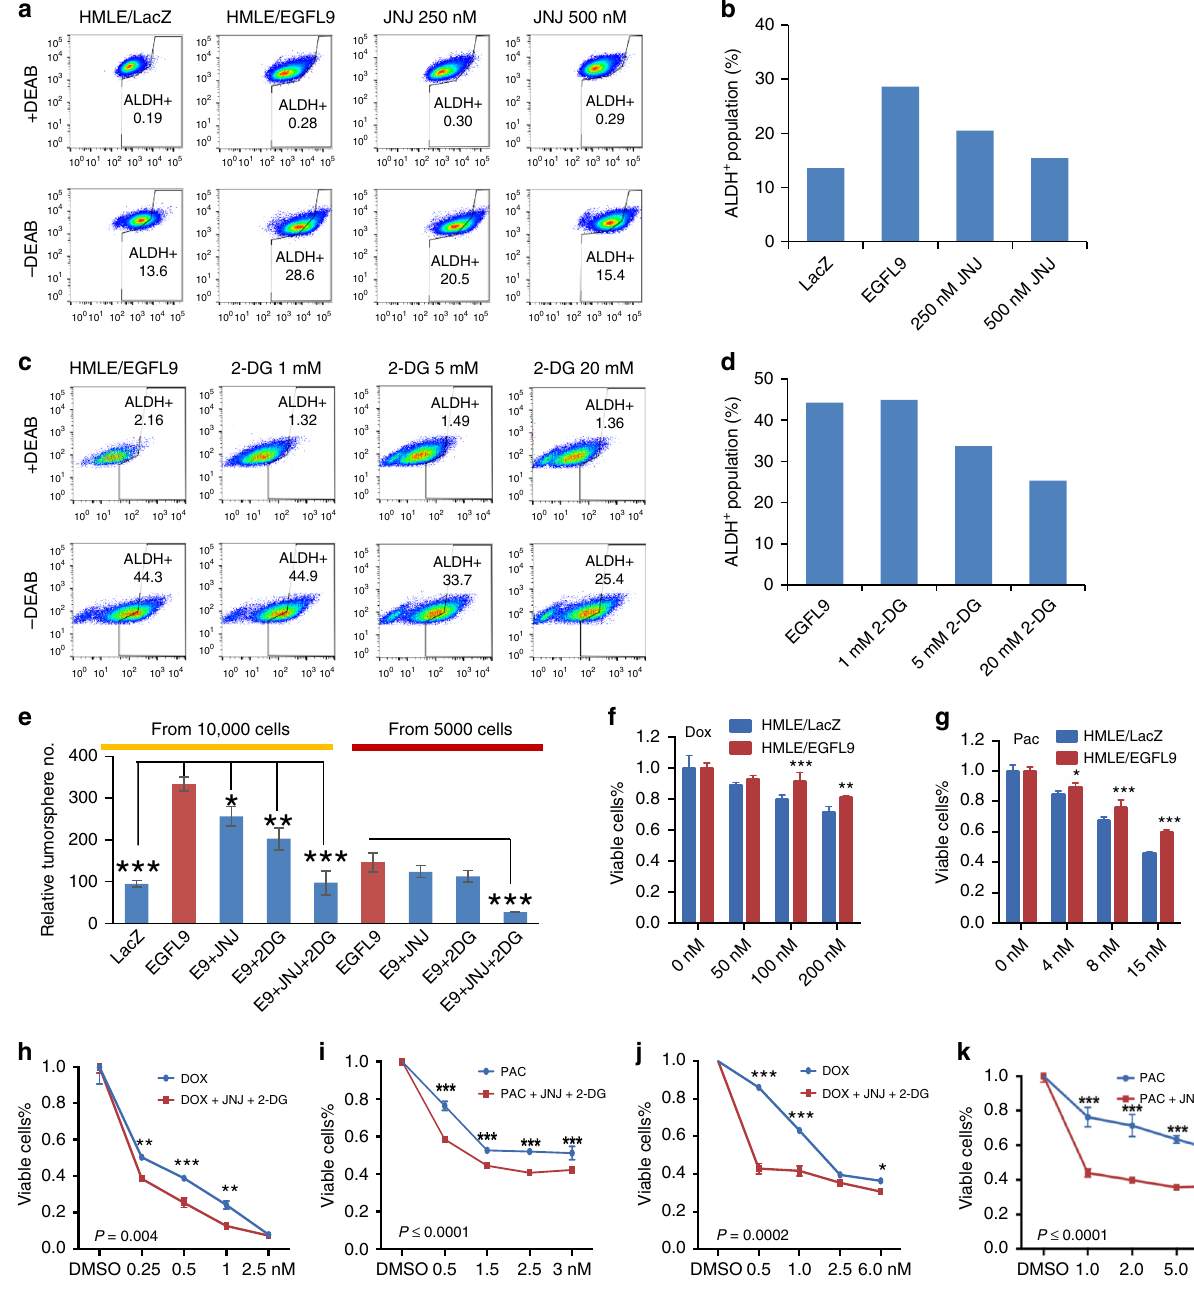
Fig. 8 EGFL9 induces stemness in mammary epithelial cell. a ALDH + FACS pro fi les are shown for HMLE/LacZ cells, and HMLE/EGFL9 cells with different doses of JNJ38877605 treatment. b Summary of percentage of ALDH + cells in HMLE cells with EGFL9 expression and 250 and 500 nM of JNJ38877605 treatment. c ALDH + FACS pro fi les are shown for HMLE/LacZ cells, and HMLE/EGFL9 cells with different doses of 2-DG treatment. d FACS analysis of the ALDH + fraction cells in HMLE cells with EGFL9 expression and 5 and 20 mM of 2-DG treatment. e Tumorsphere formation assay of HMLE/EGFL9 (1 × 10 4 and 0.5 × 10 4 ) cells with JNJ38877605 and/or 2-DG treatment. f , g The effect of EGFL9 on drug resistance in HMLE cells. Different doses of Dox ( f ) and Pac ( g ) were used to treat HMLE/LacZ and HMLE/EGFL9 cells. MTT assay was used to measured cell viability. For panels from e to g , each bar represents the mean ± SEM (standard error of the mean of a representative experiment performed in triplicate). P values were determined by unpaired two-tailed t - test. * P < 0.05; ** P < 0.01 and *** P < 0.001. h , i Treatment of JNJ38877605 (500 nM) and 2-DG (5 mM) in combination sensitizes HMLE/EGFL9 cells to Dox ( h ) and Pac ( i ) treatment. j , k Treatment of JNJ38877605 (500 nM) and 2-DG (5 mM) in combination sensitize SUM159 cells to Dox ( j ) and Pac ( k ) treatment. For panels from h to k , two-way ANOVA followed by multiple comparisons was used to compare the two values at a given concentration. * P < 0.05; ** P < 0.01; and *** P <